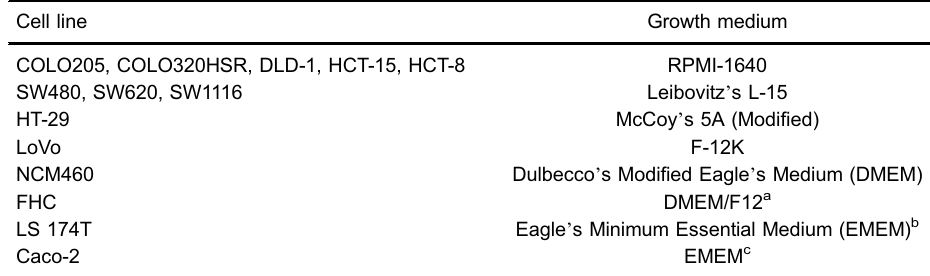
Table 1. Growth medium used for each cell